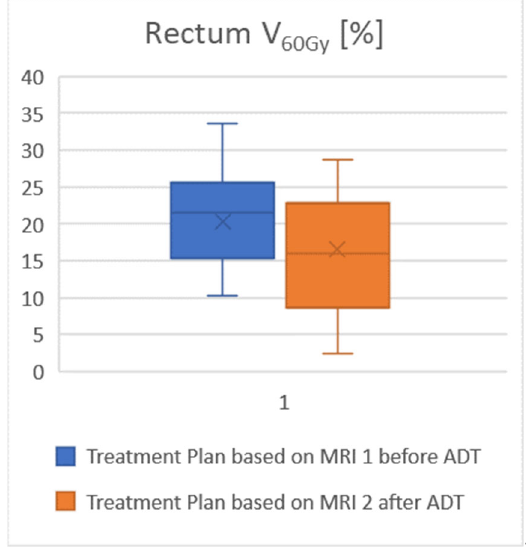
Figure 3. Attention to the reduction in prostate size after ADT by the updated MRI results in significant dose relief of the rectum. The proportion of the rectum exposed to more than 60 Gy is lower when treatment planning is performed using the current MRI 2.